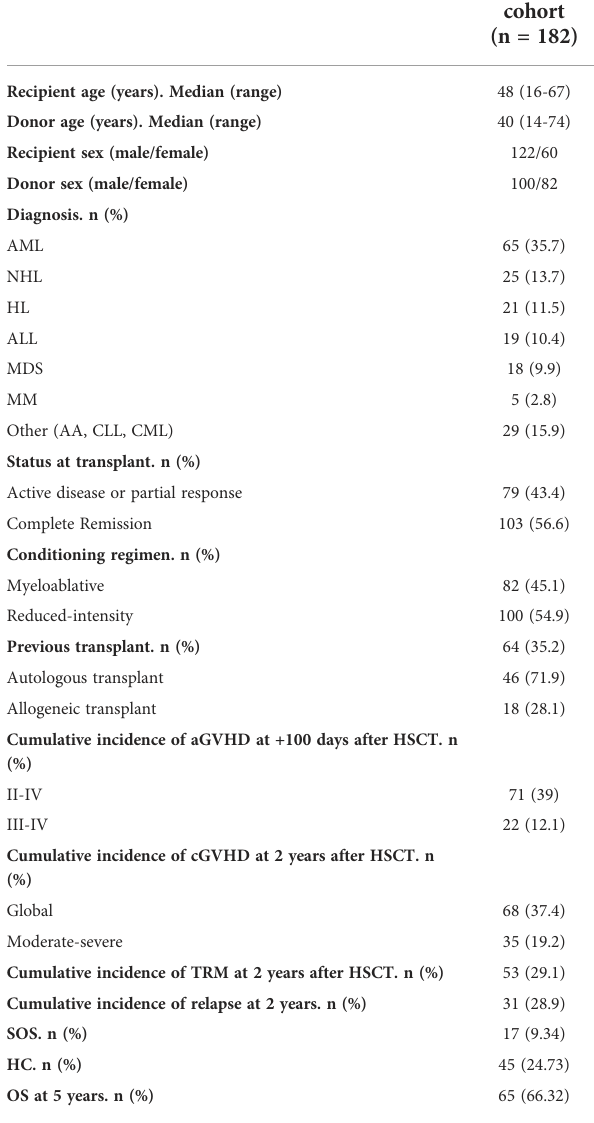
TABLE 1 Clinical characteristics of 182 patients who underwent Haplo-HSCT with PT-Cy.